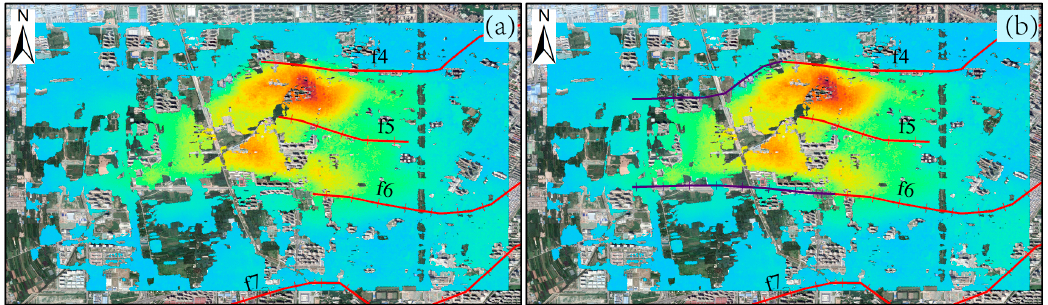
Figure 11. Updating the location of ground fissures. ( a ) The archived record of the location of fissures f4, f5 and f6; ( b ) the updated location of ground fissures f4 and f6, according to land subsidence.